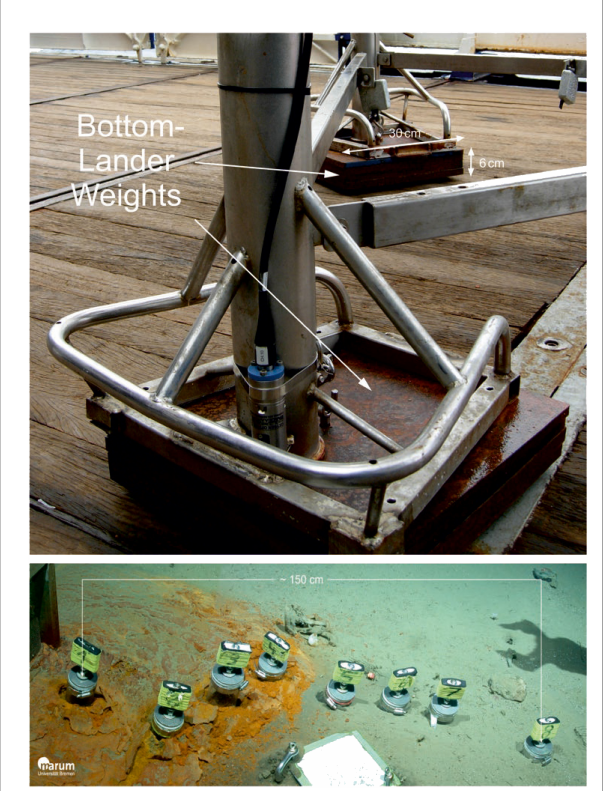
FIGURE 1 Block-shaped steel weights of a bottom-lander (above) and sediment sampling along a gradient with decreasing iron concentrations in the vicinity of corroding bottom-weights (below) using push-corers (PC1-8) handled by a Remotely Operated Vehicle QUEST 4000 ( ©